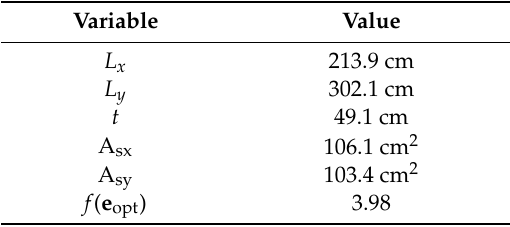
Figure 10. Example 2: Optimization algorithm progression. Table 8. Example 2: Optimum design vector and its objective value.